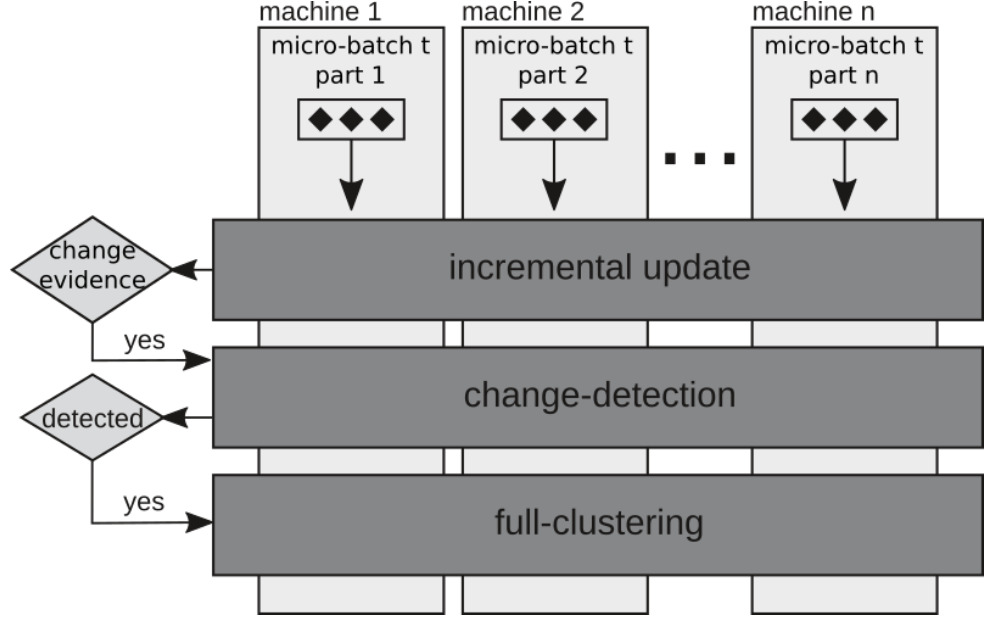
Figure 6. ISESC-CD overview, adapted from